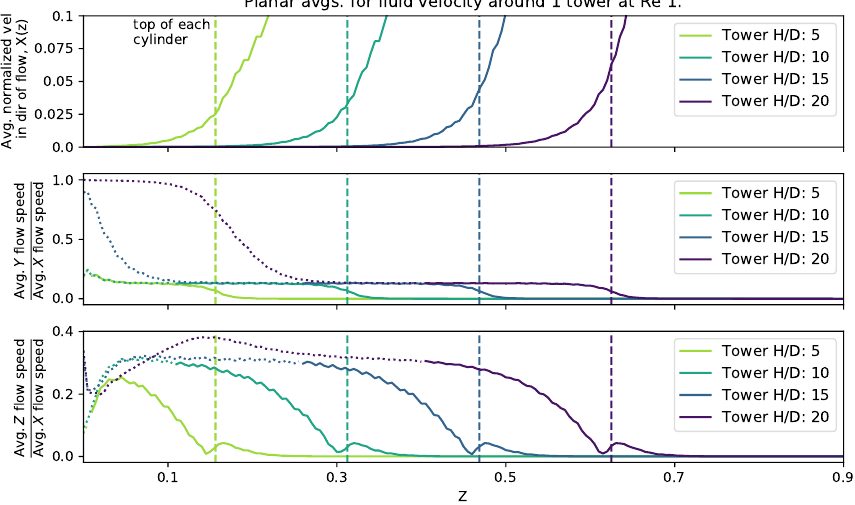
Figure 8. Magnitude of flow velocity averaged across planes perpendicular to the z -axis for four different cylinder heights. The top of each cylinder is plotted as a vertical dashed line. A dotted line has been used in the y and z plots where the average fluid velocity in the direction of the flow ( x ) falls below 1 × 10 − 5 .